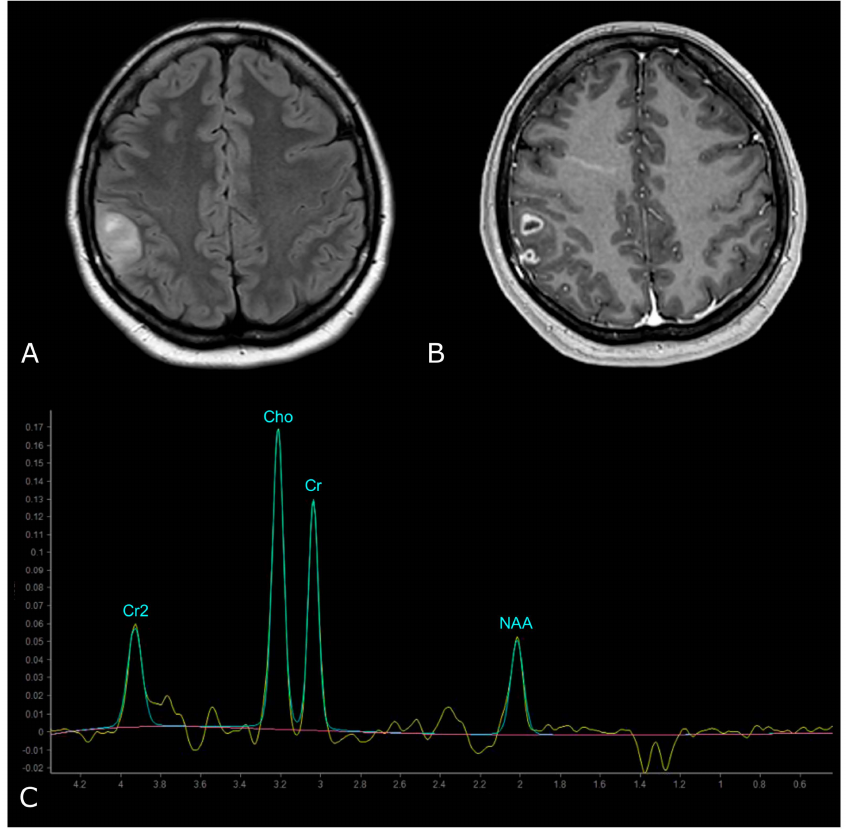
Figure 10. MR Spectrum of HGG (SV TE 144ms). ( A , B ) Axial T2-FLAIR and post-contrast T1w of